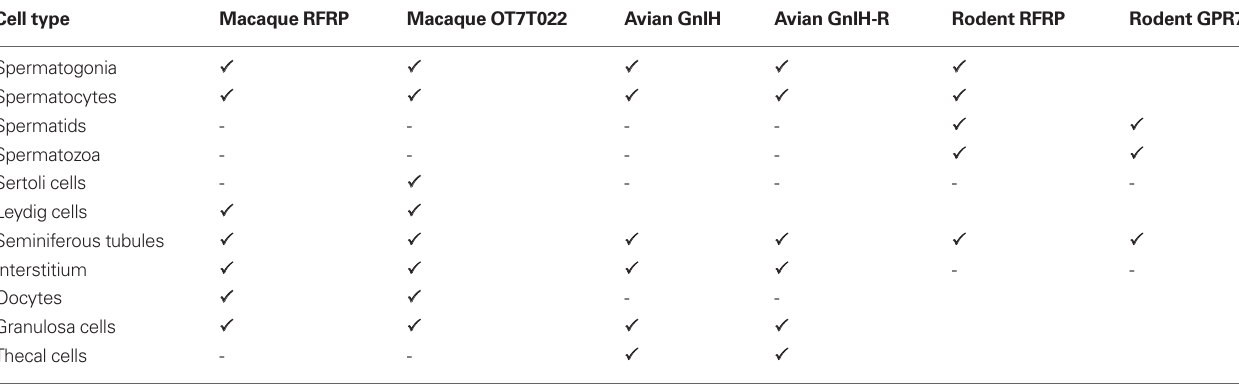
Thecal cells  Avian GnIH mRNA and peptide and GnIH-R mRNA and binding sites characterized in European starlings (Sturnus vulgaris, Bentley et al., 2008), house sparrows (Passer domesticus, McGuire and Bentley, 2010), Japanese quail (Coturnix japonica, Bentley et al., 2008) and domestic chicken (Gallus gallus, Maddineni et al., 2008). Rodent RFRP and GPR74 peptides characterized in hamster (Mesocricetus auratus, Zhao et al., 2010). Checkmarks indicate presence in the cell type, dashes denote lack of mRNA, peptide or binding sites and blank spaces indicate lack of evidence.